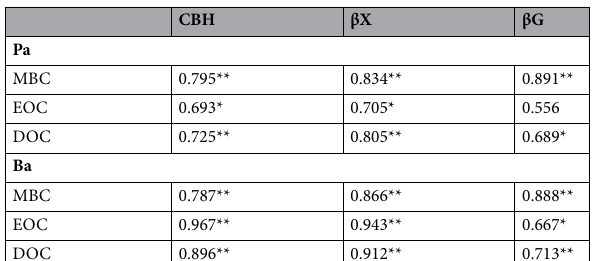
Table 3. Correlation analysis between soil active organic carbon and enzyme activities. *Correlation is significant at the 0.05 level, **Correlation is significant at the 0.01 level; Pa: Picea asperata Mast.; Ba: Betula albosinensis ; MBC: microbial biomass carbon, EOC: easily oxidized organic carbon, DOC: dissolved organic carbon; SOC: soil organic carbon; CBH: Cellobiohydrolase, βG: β-1,4-glucosidase, βX: β-1,4-xylosidase (data in this table is analyzed by SPSS, version 20.0, 2011, SPSS Inc., Chicago, IL, USA; software available at: https :// www.ibm.com/analy tics/spss-stati stics -softw are).